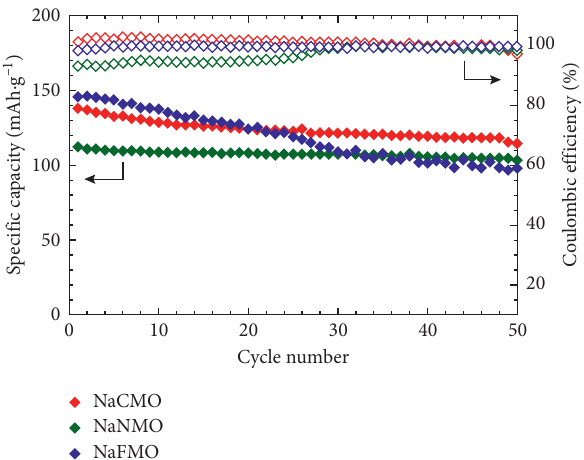
Figure 5: Cycling retention and coulombic efficiency of NaCMO, NaNMO, and NaFMO in 50 cycles in sodium